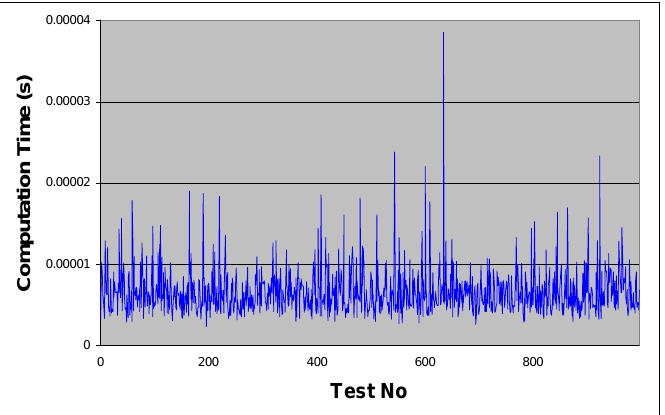
Figure 10. LCS algorithm performance.